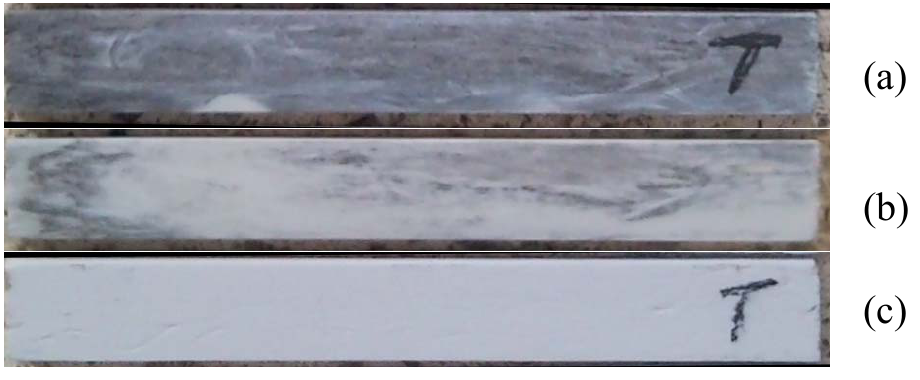
Figure 4. A single carbon coated Nextel 440 fiber reinforced MEYEB sample after exposure to: (a) 250 °C for 5 hrs, (b) 250 °C for 5 hrs + 650 °C for 5 hrs, and (c) 250 °C for 5 hrs + 650 °C for 5 hrs + 900 °C for 5 hrs, all in